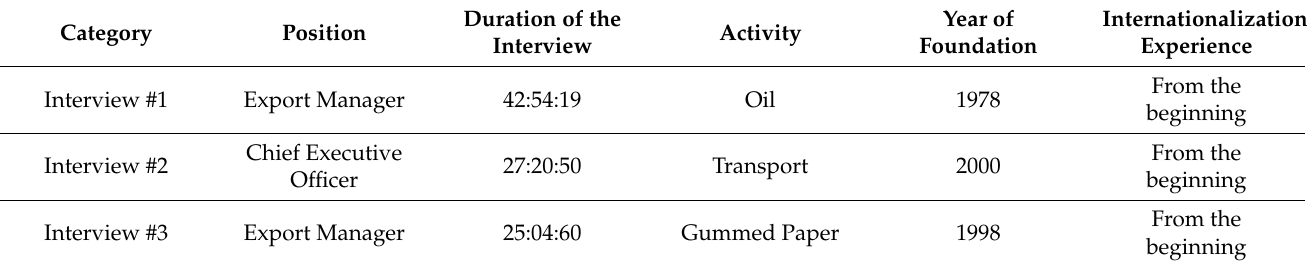
Table 2. Interviews and interviewees